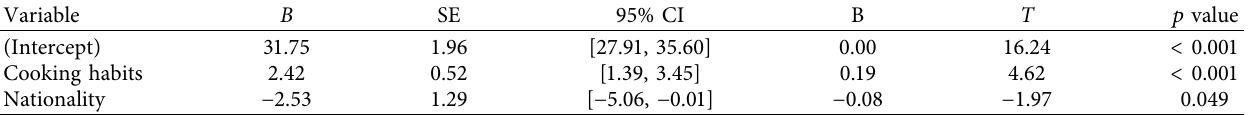
Table 5: Result for linear regression with cooking habits and nationality predicting the percentage of total correct scores. Variable B SE